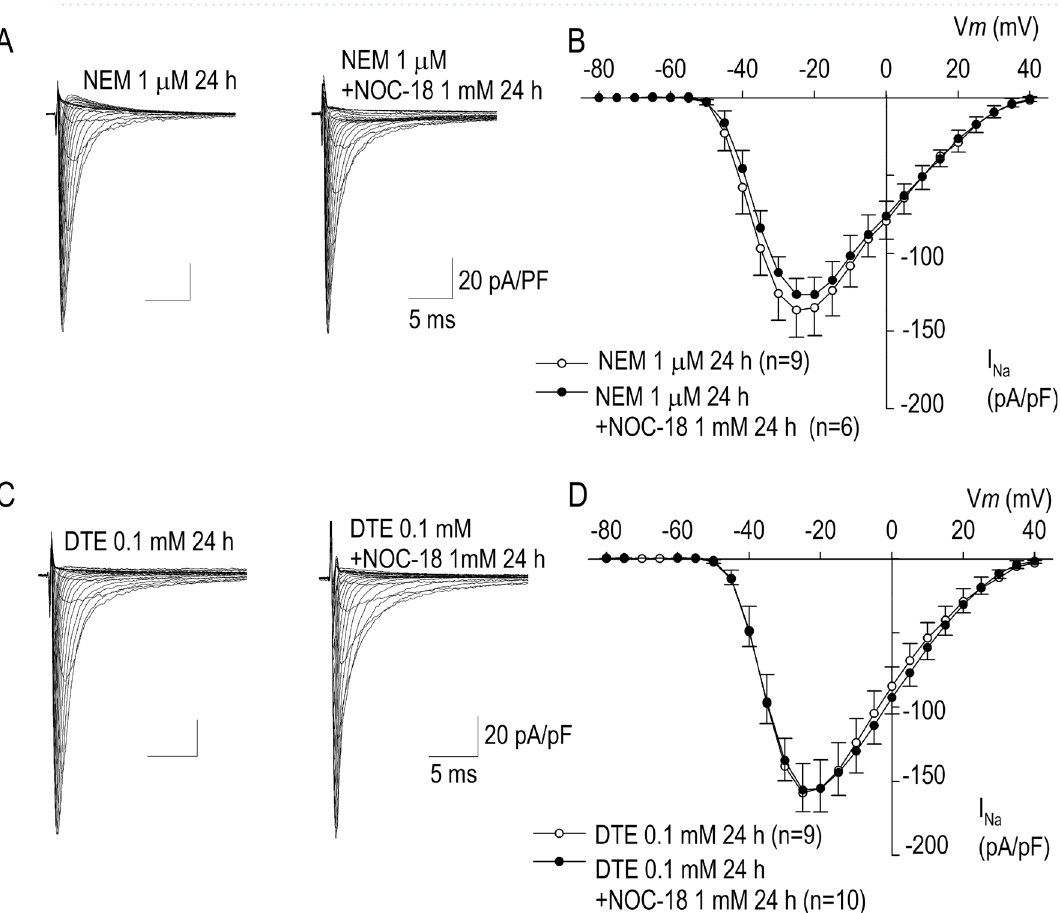
Figure 4. Effects of a sulfhydryl-reducing agent N -ethylmaleimide (NEM) and a thiol-reducing agent dithiothreital (DTE) on NOC-18 for I Na modulation. ( A , B ) Representative I Na traces with 1 mM NOC-18 applied for 24 h in the absence or presence of NEM, and their I–V relationships of I Na . ( C , D ) Representative I Na traces with 1 mM NOC-18 applied for 24 h in the absence or presence of DTE, and their I–V relationships of I Na . In the presence of NEM or DTE, NOC-18 was unable to reduce I Na . Numbers of cell are shown in parentheses. Values represent the mean ±